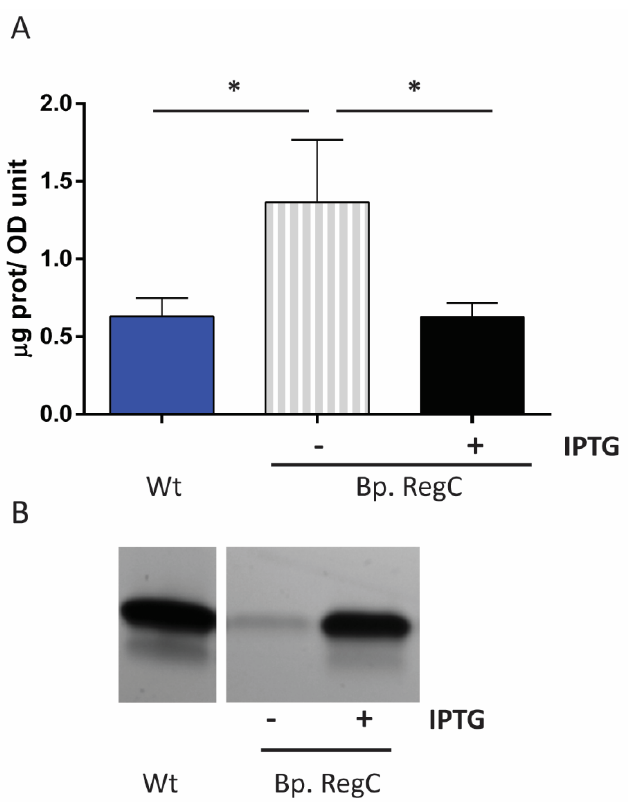
Figure 4. Influence of LPS depletion on OMV production. OMVs were isolated from the supernatant of the same volumes of cultures of the wild-type strain (Wt) and of the Bp. RegC strain obtained at T 3 as defined in Figure 2A following the LPS-depletion protocol with or without IPTG. ( A ) OMVs were quantified based on protein content using a Lowry assay. Protein content is depicted as the amount of protein in the OMV fractions per liter of bacterial culture per OD 600 unit. Values shown are means and standard deviations from three independent experiments, and significant differences are indicated with asterisks ( p ≤ 0.05); ( B ) LPS in the isolated OMVs was analyzed by SDS-PAGE after adjusting the samples to similar protein content, and the LPS was visualized in the gel by silver staining.